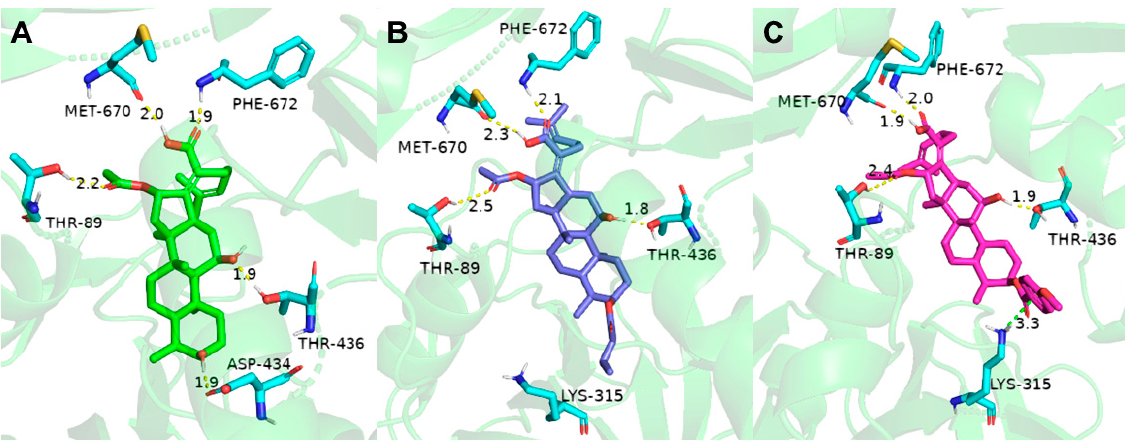
Figure 4. Docking models of FA and FA derivatives into EF-G: ( A ) binding mode of EF-G and FA, ( B ) mode compound FA-3 docked in the cleavage site of EF-G, and ( C ) mode compound FA-15 docked in the cleavage site of EF-G. The ligands FA, FA-3, and FA-15 are shown as green, blue, and magenta sticks, respectively; the vital amino acid residues are shown as cyan sticks; and the H-bond and π - cation interaction are shown as yellow and green dotted lines, respectively.